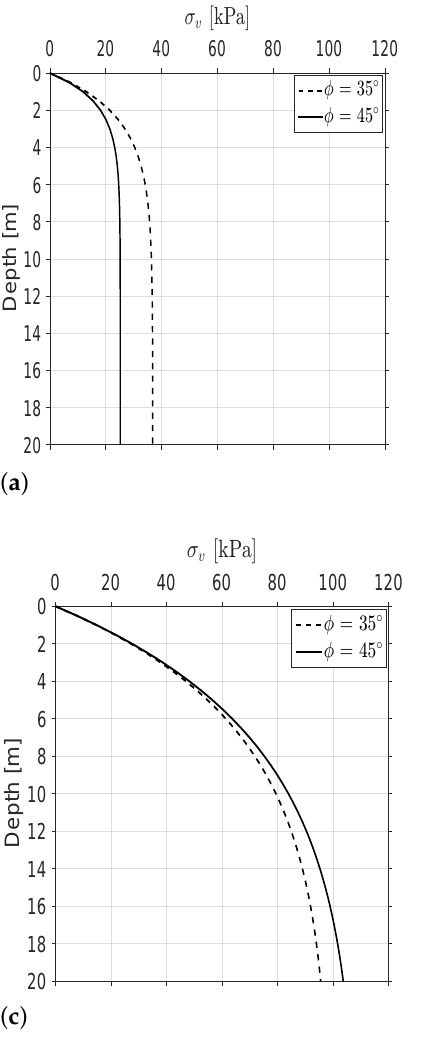
Figure 13. Vertical stress distribution in different models: ( a ) Anagnostou and Kovari [7] model; ( b ) Broere [8] model; ( c ) Jancsecz and Steiner [6]